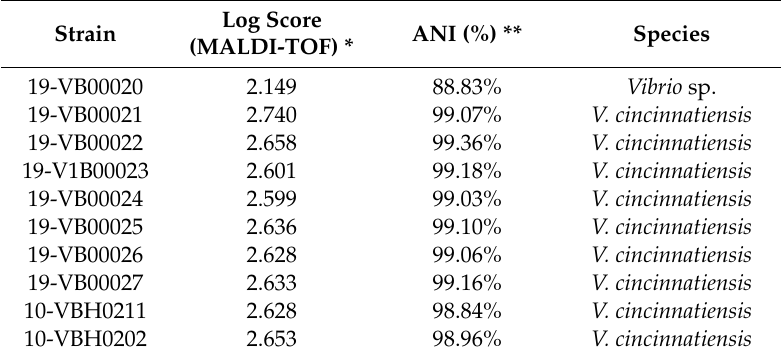
Table 2. Species identification: Results of MALDI-TOF MS (matrix-assisted-laser-desorption / ionization time-of-flight mass spectrometry) and average nucleotide identity (ANI) by comparison with the reference strain NCTC12012. Log Score ANI (%) Strain (MALDI-TOF) *